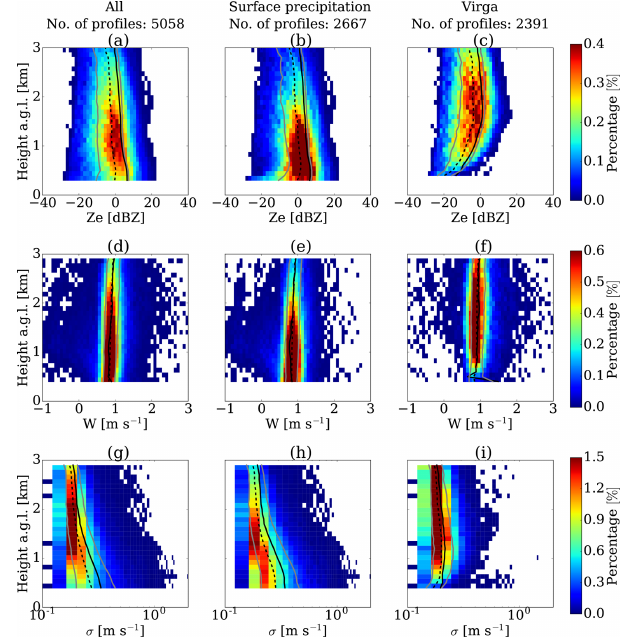
Figure 5. Same as Fig. 4, but for the Princess Elisabeth